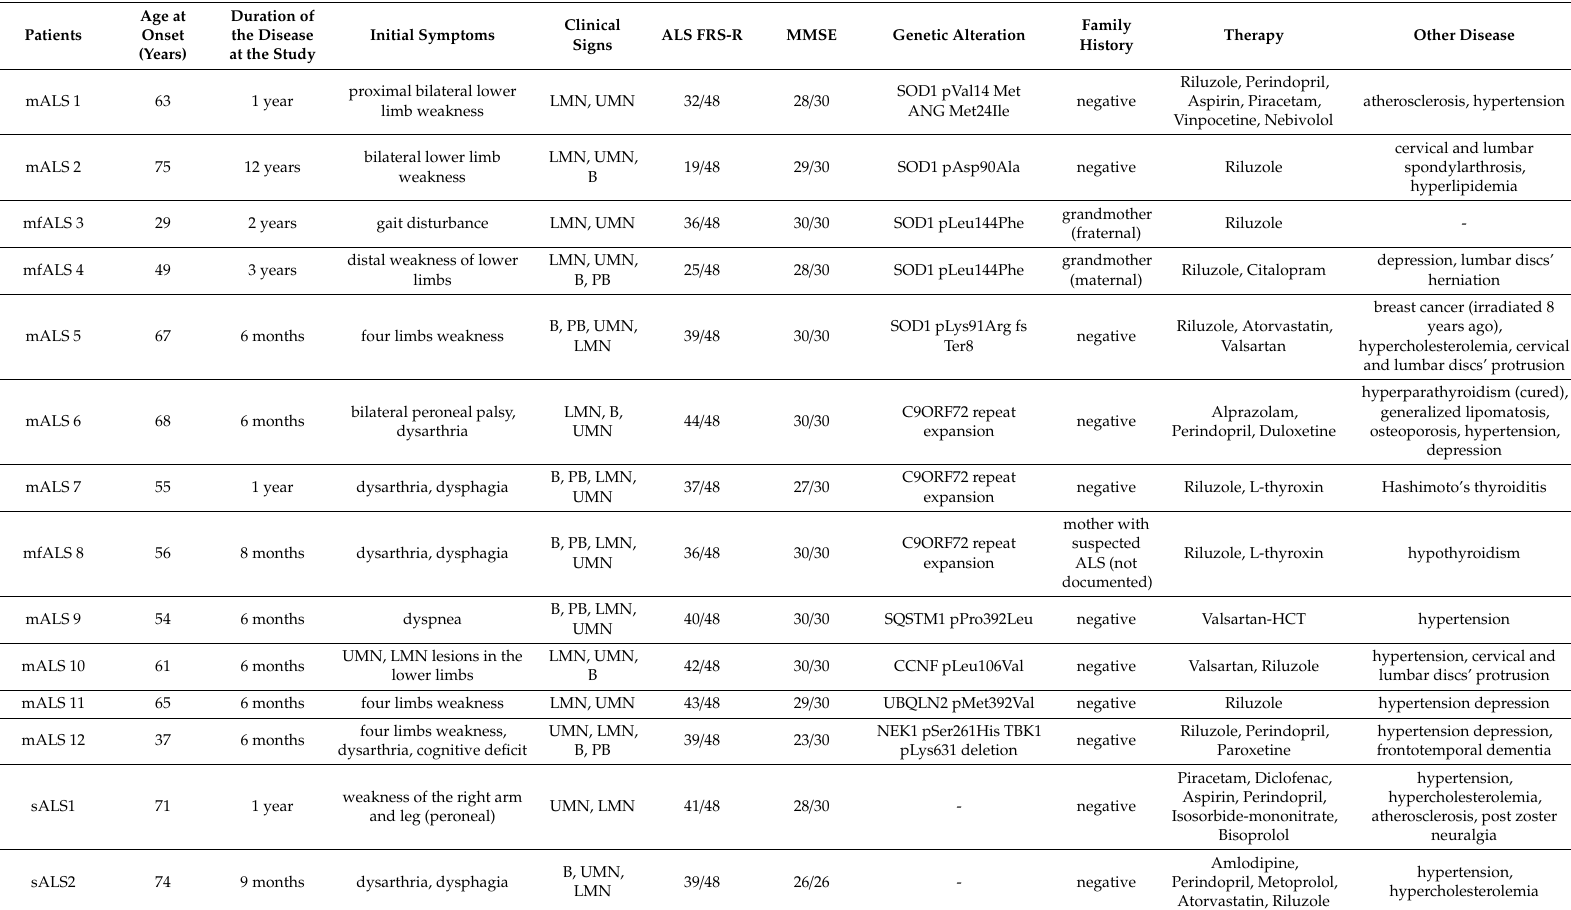
Table 1. Summary of the clinical data of the